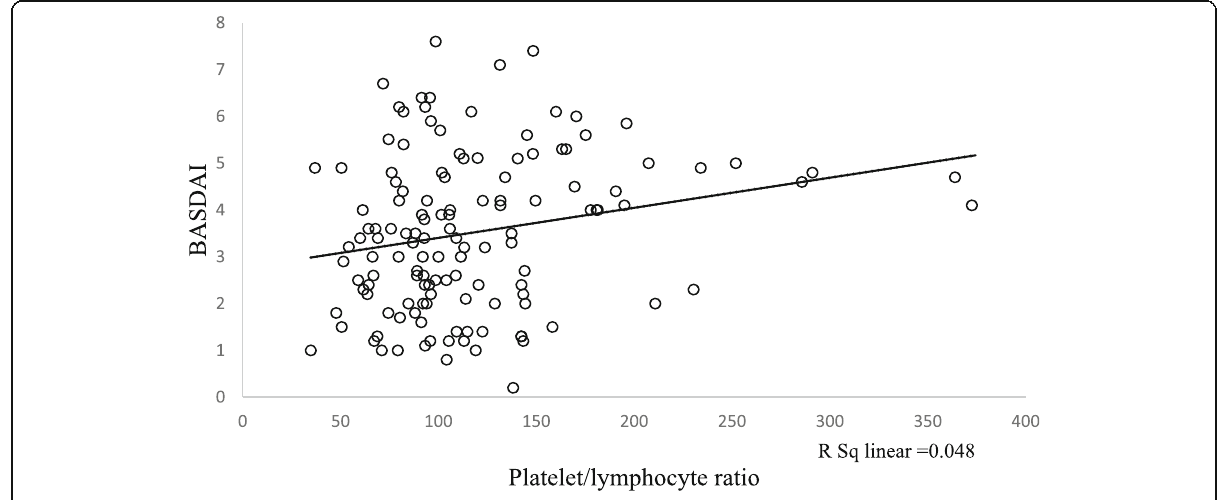
Fig. 4 Correlation between BASDAI scores and platelet/lymphocyte ratio in patients with ankylosing spondylitis ( p =